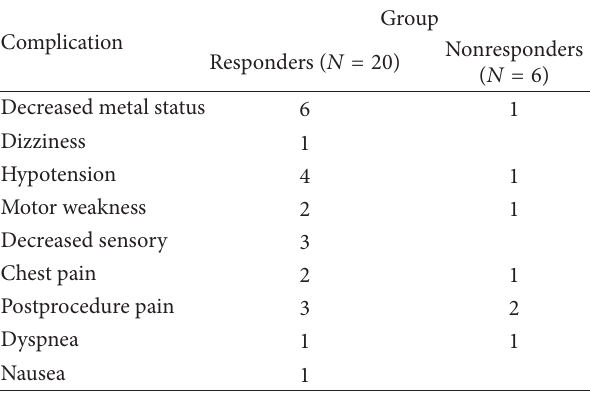
The data are presented as absolute